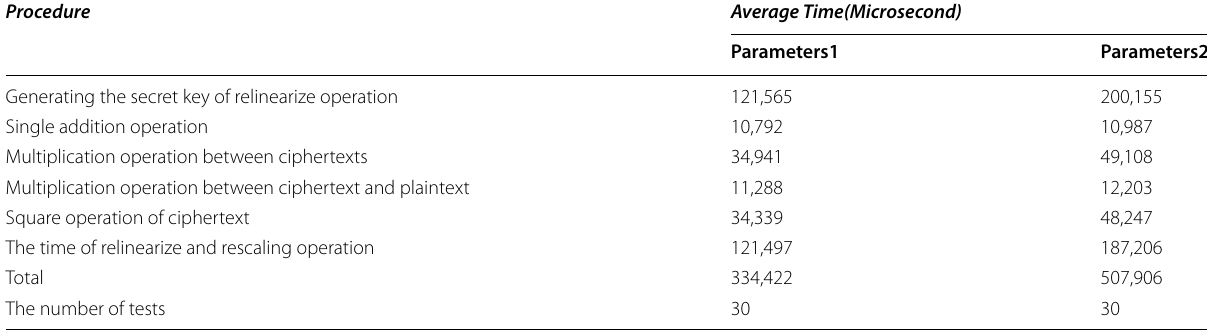
Table 4 Encryption time